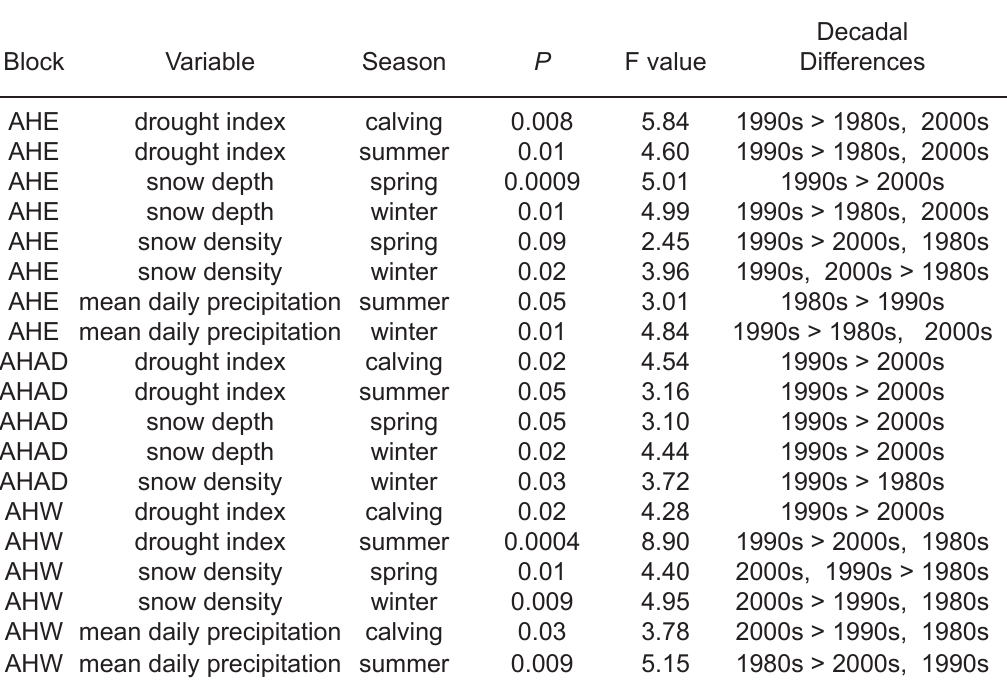
Table 4. Significant differences for snow depth, daily precipitation and daily temperature (ANOVA and Duncan’s- Waller multiple range tests) among decades based on MERRA climate